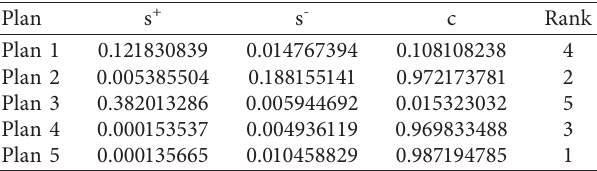
Table 5: Positive and negative ideal solutions and their relative